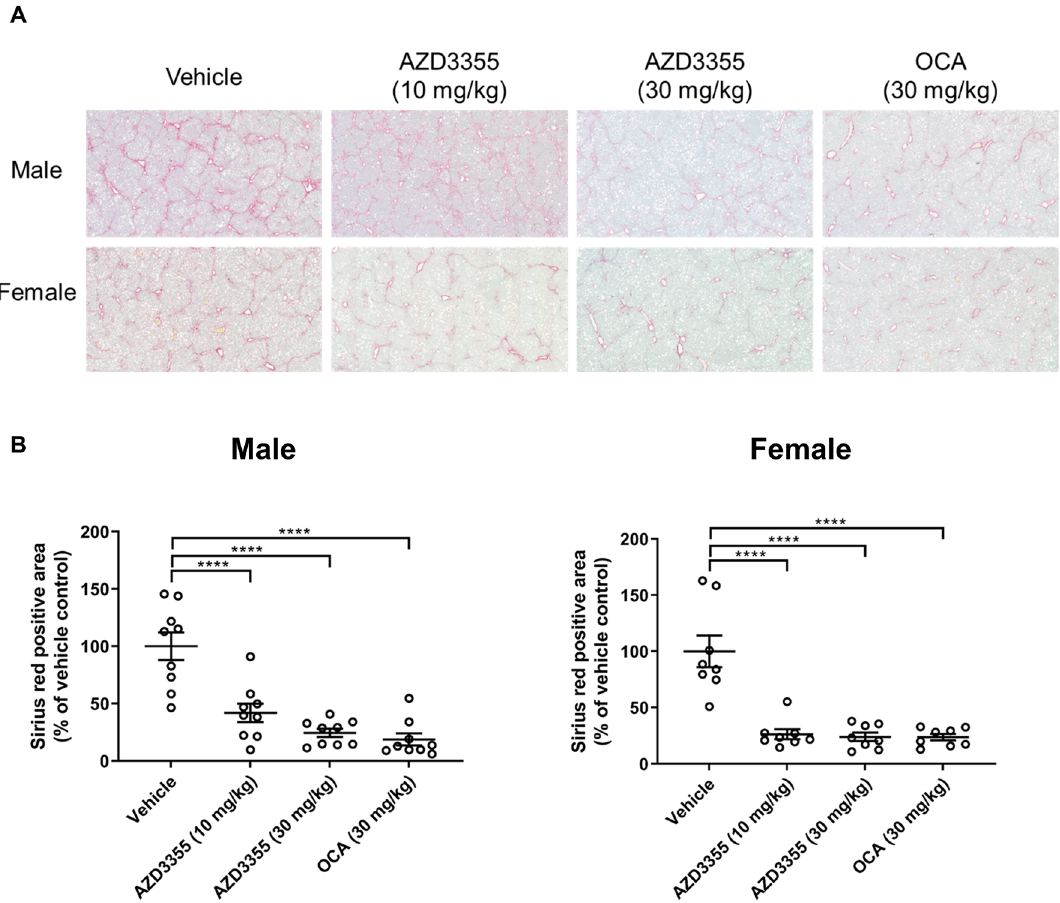
Figure 6. Hepatic collagen deposition is reduced by AZD3355 treatment in a murine NASH model. Representative photomicrographs (20 X magnification) of Sirius Red stained liver sections ( A ) from male and female mice treated with either vehicle or AZD3355 (10 and 30 mg/kg) and OCA (30 mg/kg). Morphometric quantification of Sirius Red-positive area ( B ) was performed using BIOQUANT image analysis software. Dose dependent reduction of hepatic fibrillar collagen formation by AZD3355 treatment in both male and female mice was assesed. Vehicle: n = 9 male, 8 female; AZD3355 (10 mg/kg): n = 9 male, 8 female; AZD3355 (30 mg/kg): n = 9 males, 8 females ; OCA (30 mg/kg): n = 9 male, 8 female animals. Results were expressed as means ± SEM.* p < 0.05, ** p < 0.01, *** p <